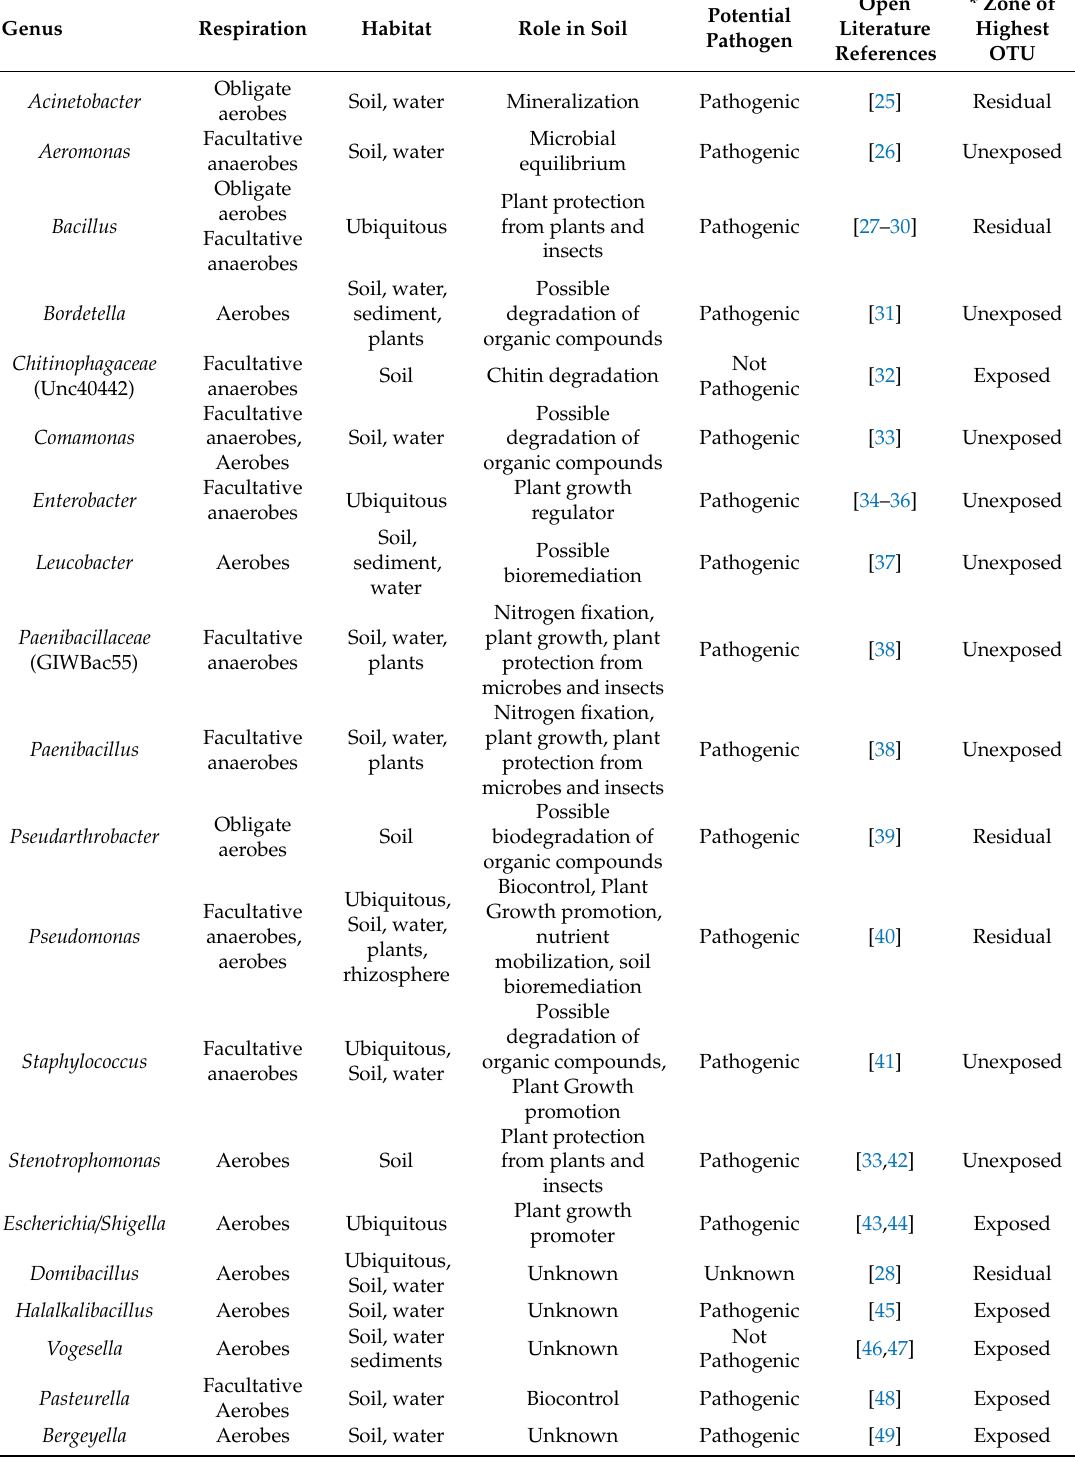
Table 2. Description of the most prevalent bacteria genera detected in the soil